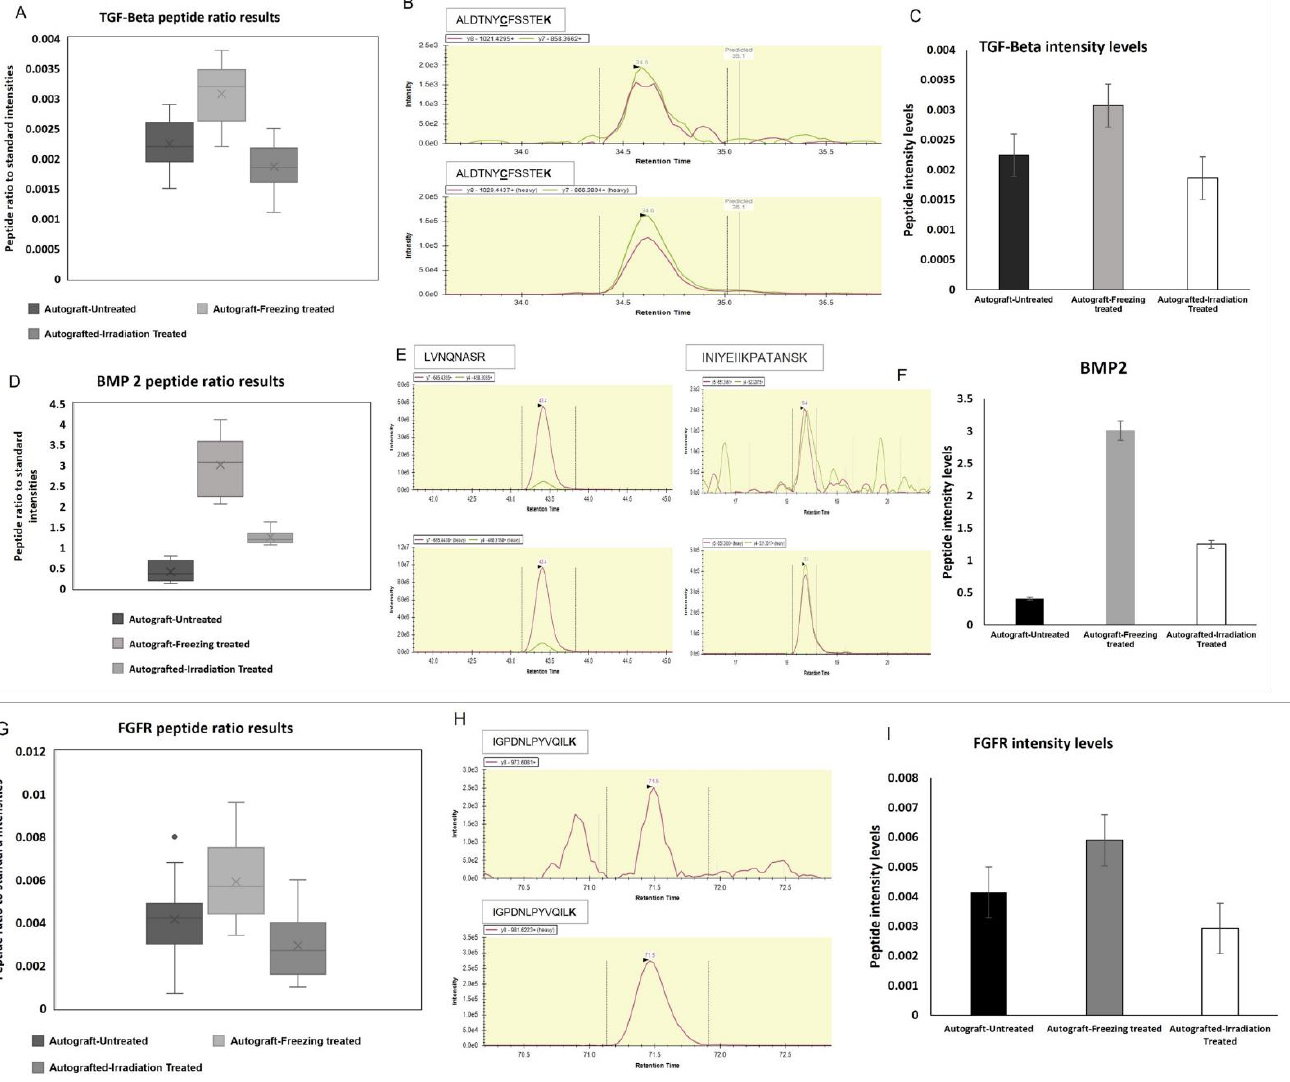
Figure 7. Three proteins (BMP2, TGF-Beta, and FGFR) were detected by target proteomic analysis. ( A ) TGF-Beta endogenous peptides detection to the heavy spiked standard ratios were illustrated ( B ) Detectability of TGF-Beta light to heavy peptides identification ( C ) Comparison of TGF-beta endogenous intensity levels among three groups of autografts. ( D ) BMP2 protein endogenous peptides detection to the heavy spiked standard ratios were illustrated ( E ) Detectability of BMP2 light to heavy peptides identification ( F ) Comparison of FGFR endogenous intensity levels among three groups of autografts ( G ) FGFR detection of endogenous peptides to the heavy spiked standard ratios were illustrated, the gray dot represents any data not included between the whiskers is an outlier ( H ) Detectability of FGFR light to heavy peptides ( I ) Comparison of FGFR endogenous intensity levels among three groups of autografts.